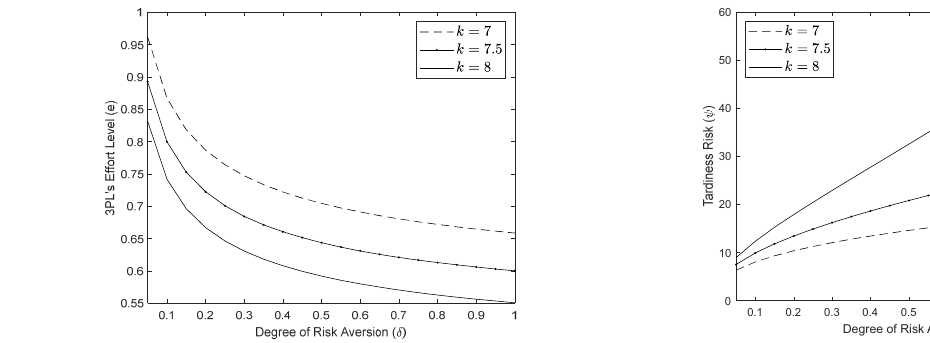
Fig. 5. The effect of degree of risk aversion on tardiness